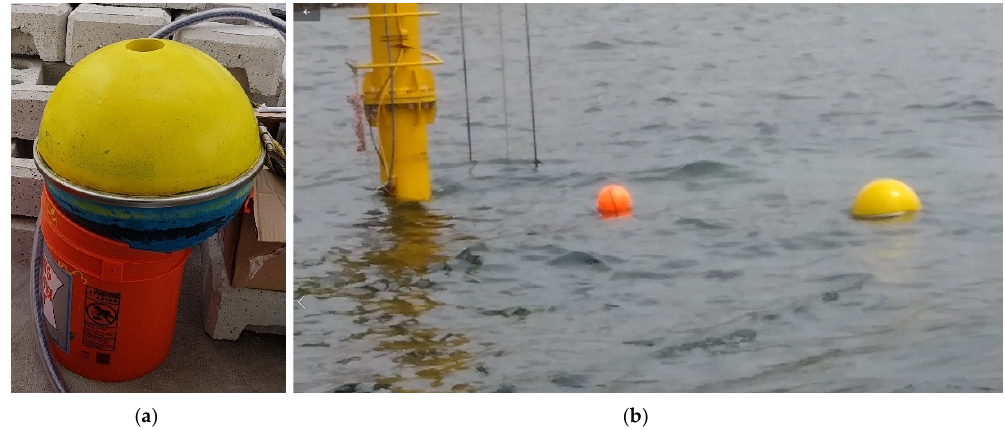
Figure 7. The directional wave spectra drifter (DWSD) buoy: ( a ) ashore, prior to launching; ( b ) right after deployment at MEDA-B. The orange float required for the mooring system is also shown.